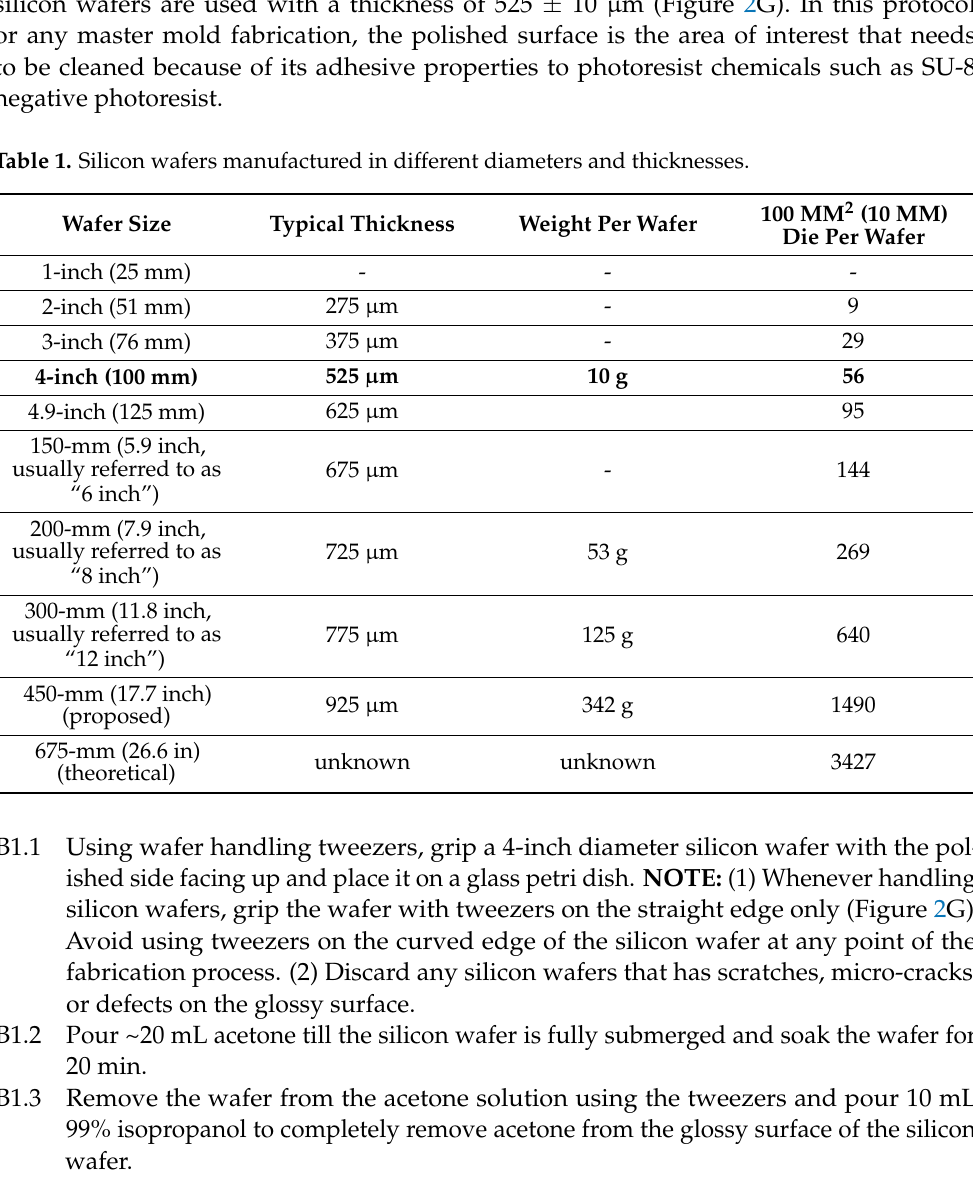
2 (10 MM) Die Per